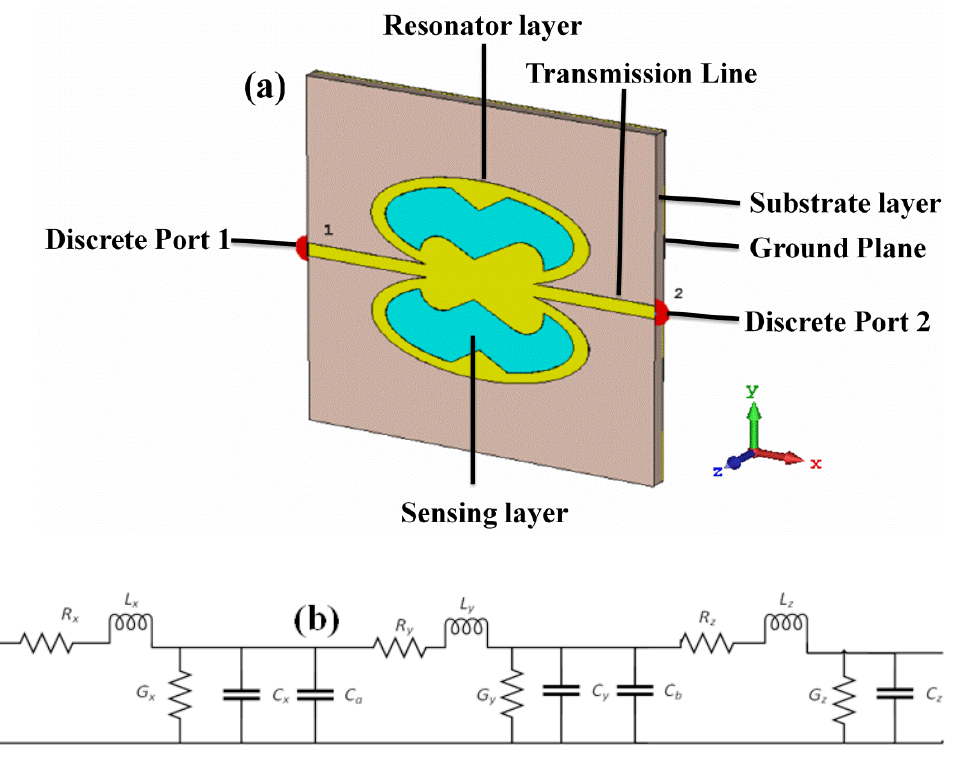
Figure 1. ( a ) The metamaterial-based sensor: 3D view and ( b ) its equivalent circuit model.